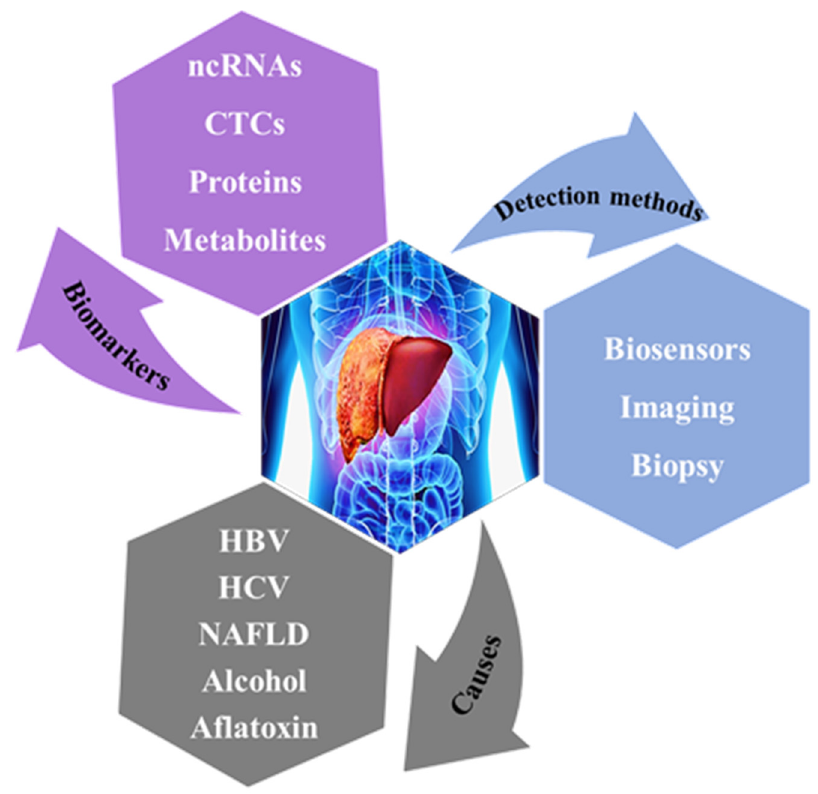
Figure 1. Schematic of liver cancer-associated incidence causes, biomarkers and detection methods.